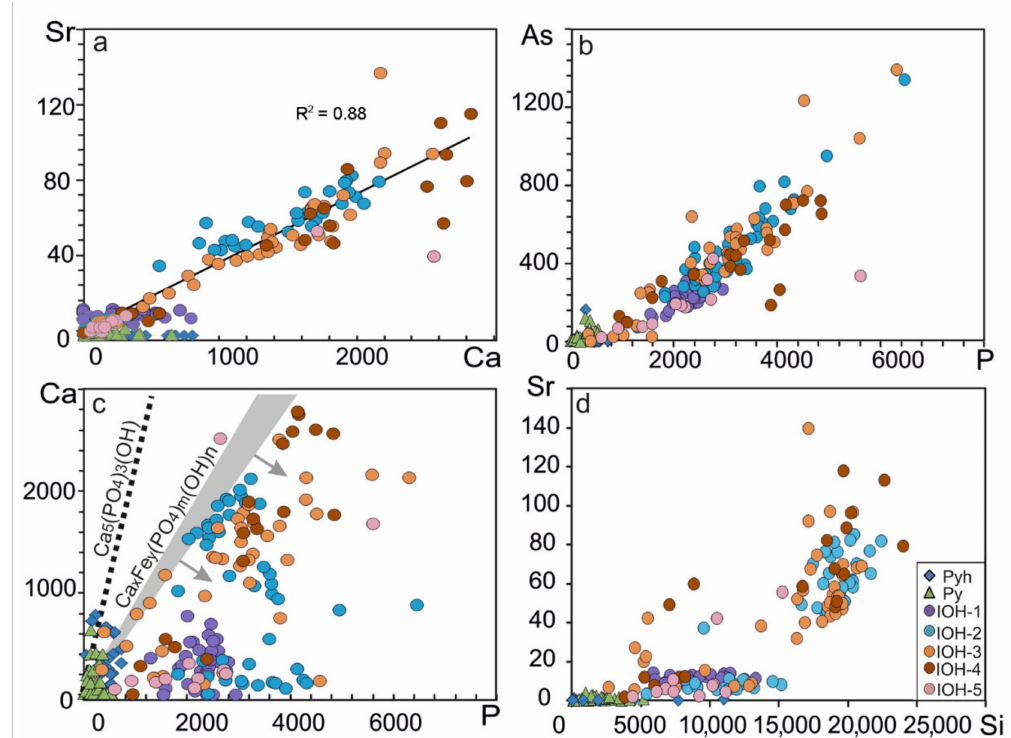
Figure 8. Bivariate plots of: ( a ) Ca vs. Sr; ( b ) P vs. As; ( c ) P vs. Ca; and ( d ) Si vs. Sr for the iron oxyhydroxides (IOH), pyrite (Py) and pyrrhotite (Pyh) of the Pobeda-1 hydrothermal field